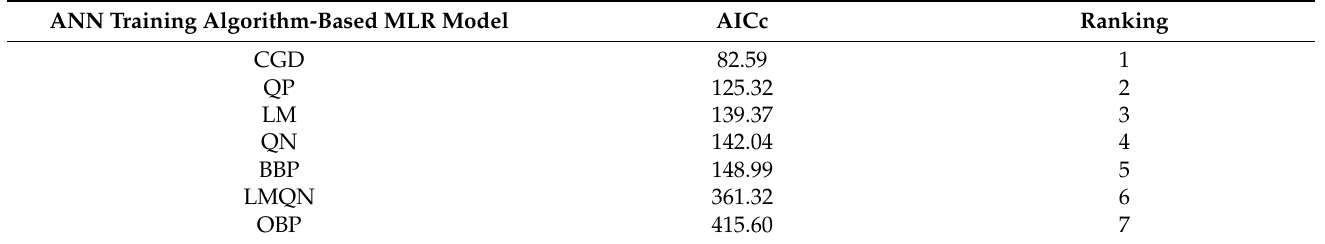
Table 6. Results of the Akaike information criterion for ANN training algorithm-based MLR models. ANN Training Algorithm-Based MLR